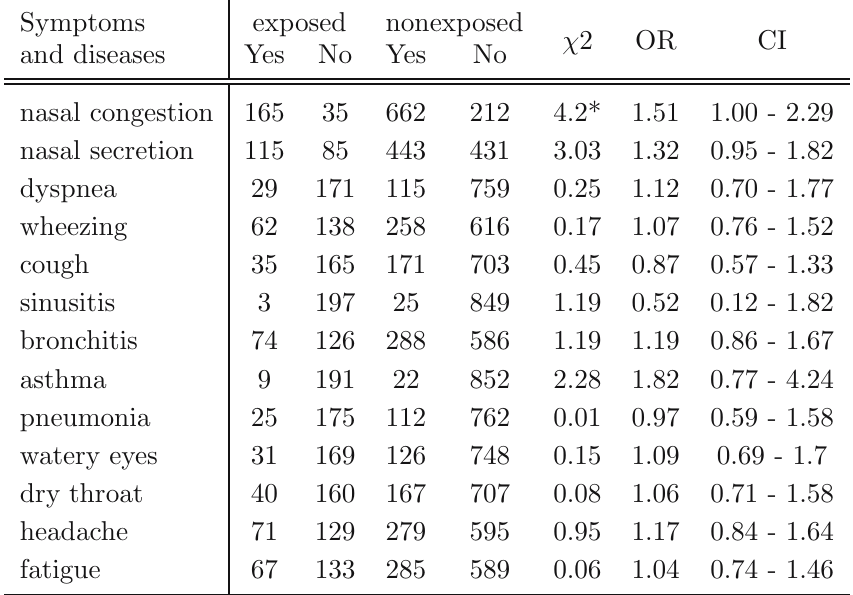
Table 6 Exposure to pets allergens and its influence on children’s